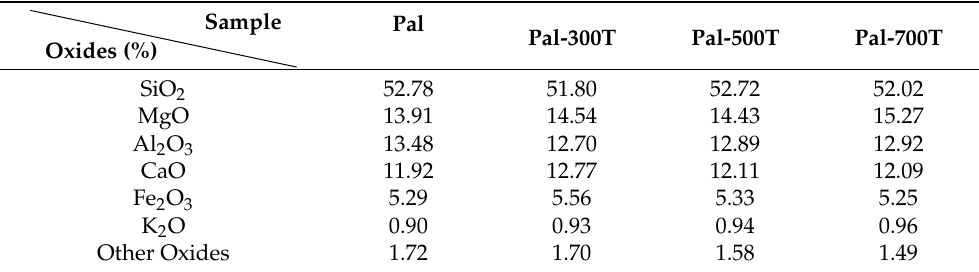
Table 1. Chemical composition (wt %) of natural and heat-treated palygorskite samples (300, 500 and 700 °C). The margin of error was 3%.